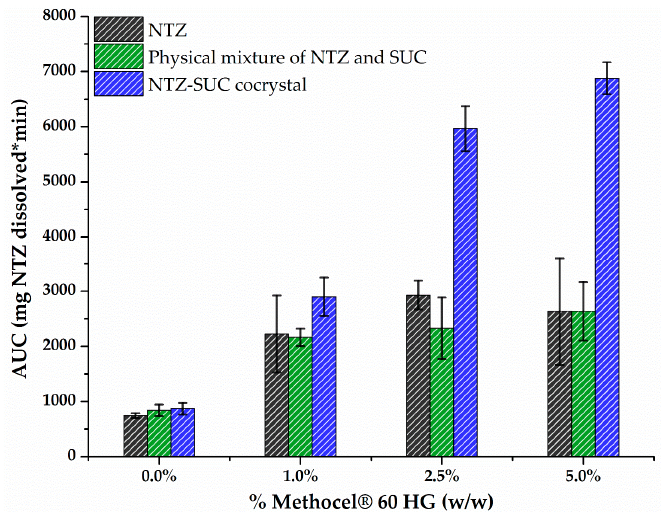
Figure 7. AUC of NTZ extracted from the dissolution profiles in pH 7.5 PBS for the following solid phases, which were formulated with different amounts of Methocel ® 60 HG (0.0, 1.0, 2.5 and 5.0%, w / w ): NTZ, 2:1 physical mixture of NTZ and SUC, and NTZ-SUC cocrystal.